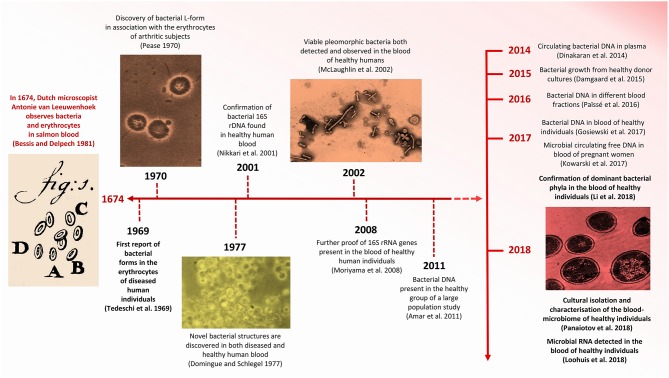
Timeline indicating significant advances concerning HBM research. Images modified from Pease (1970), Domingue and Schlegel (1977), Bessis and Delpech (1981), McLaughlin et al. (2002), and Panaiotov et al. (2018).